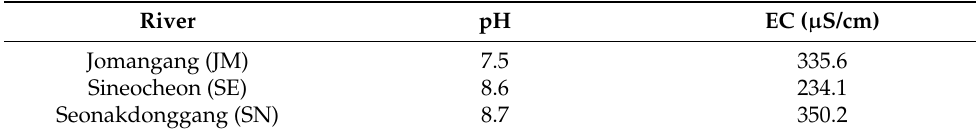
Figure 2. Water sampling points in Republic of Korea. Table 2. pH and EC values of selected solvents for rivers.